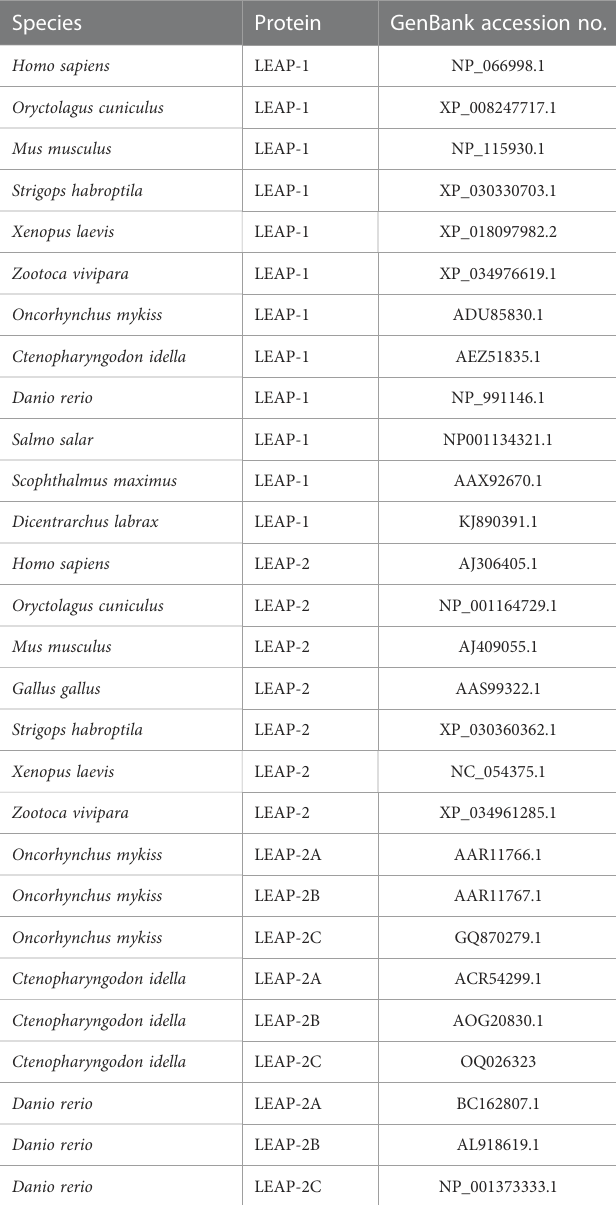
TABLE 1 LEAP sequences used in this